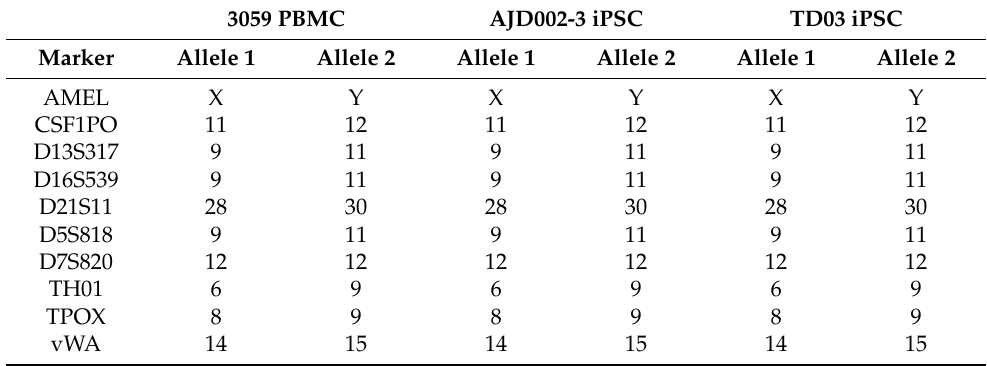
Table 2. Representative STR profiling of AJD002-3 and TD03 for